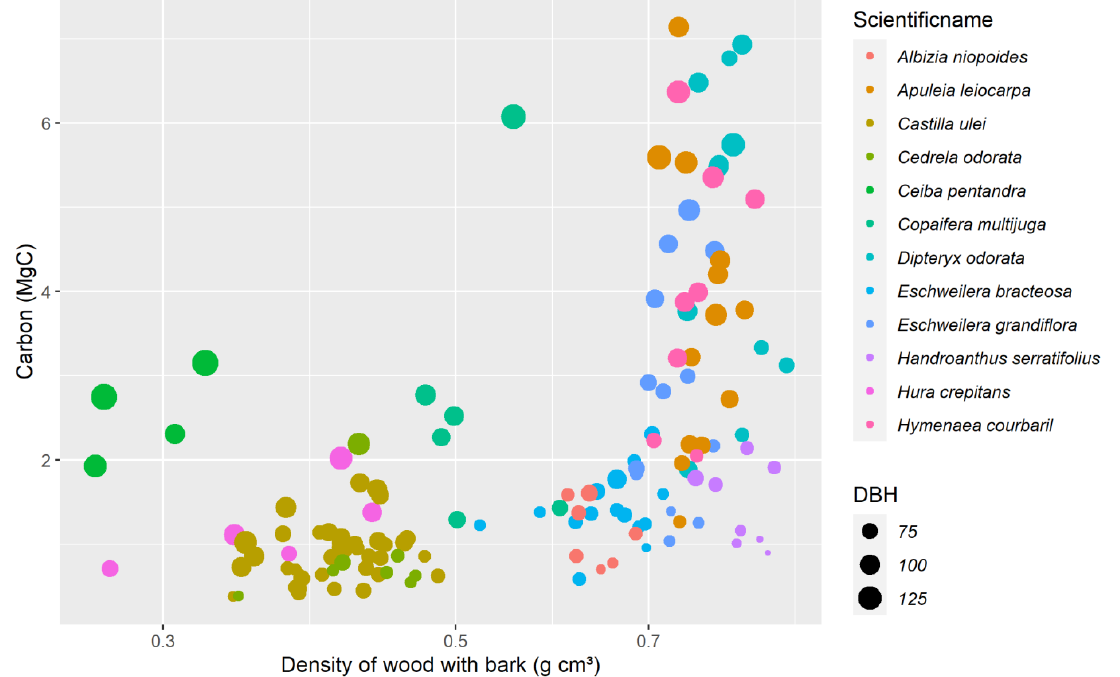
Figure 2. Relationship between carbon stock in a 1252.8-ha harvested area and wood density (g cm − 3 ). The size of the dots is proportional to the DBH of the individual trees, and the colors indicate the species. The points in the graph correspond to the 136 individual trees sampled.